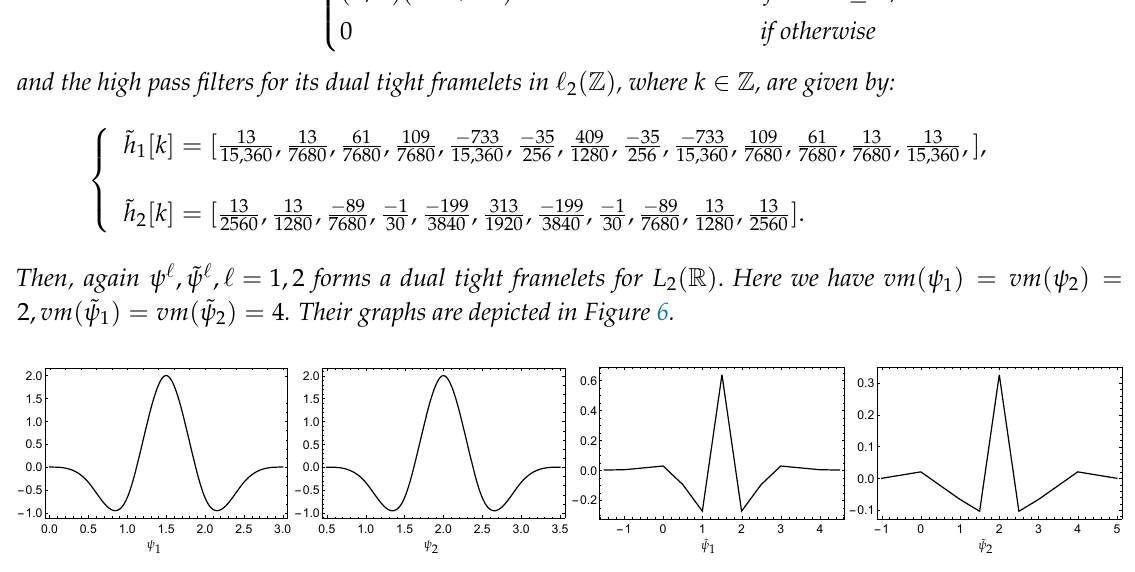
Figure 6. The graphs of the framelets and its dual framelets of Example